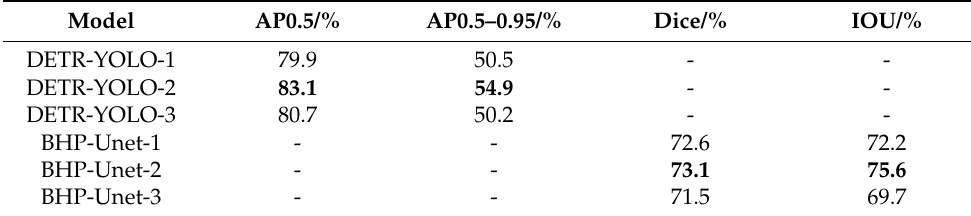
Table 5. Performances of the models trained with different sets.